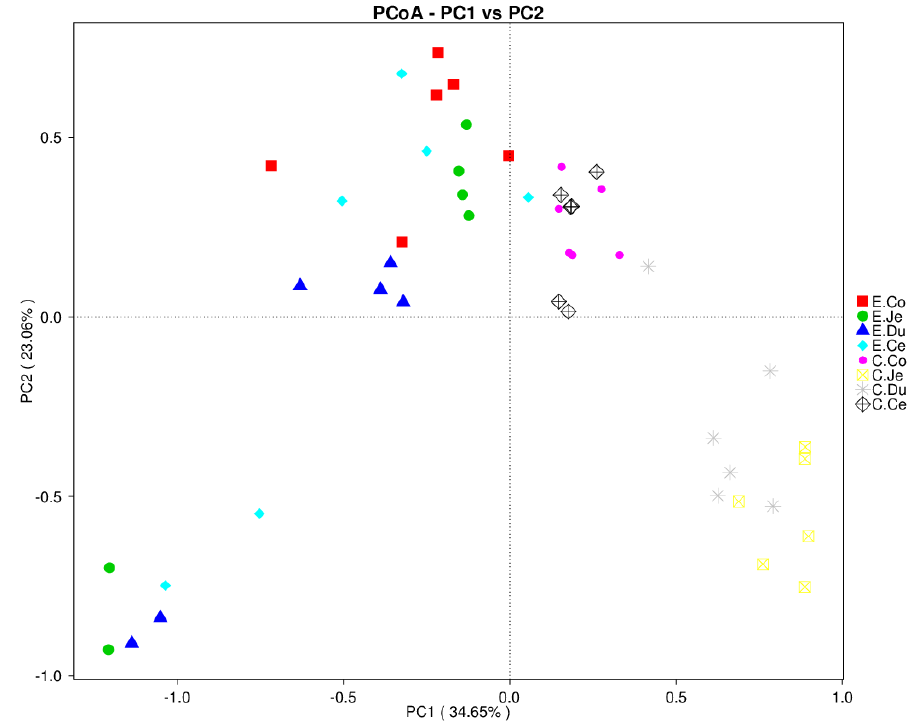
Figure 4. Analysis of beta diversity index of bacteria in four intestinal segments (FIS). Principle coordinates analysis (PCoA) of bacterial communities in FIS of Dia ( n = 6) and Con ( n = 6). The PCoA of bacterial communities in all samples based on weighted Unifrac. C, control group (Con, n = 6); E, diarrhea group (Dia, n = 6), Co, colon; Ce, cecum; Du, duodenum; Je, jejunum.